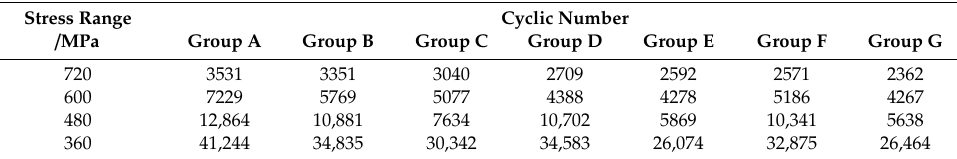
Table 4. The life of steel wire in groups